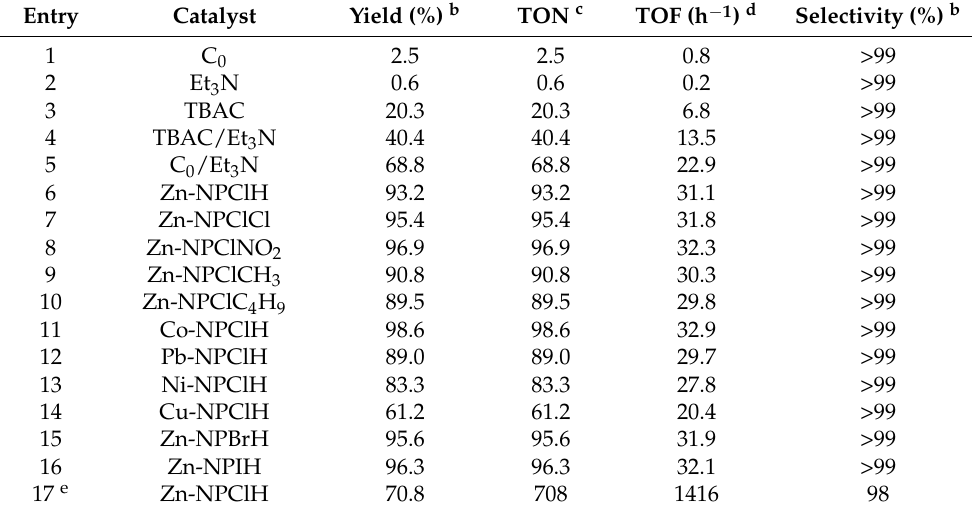
Table 1. Effect of different kinds of catalyst systems on the coupling of CO 2 with PO a . Entry Catalyst Yield (%) b TON c